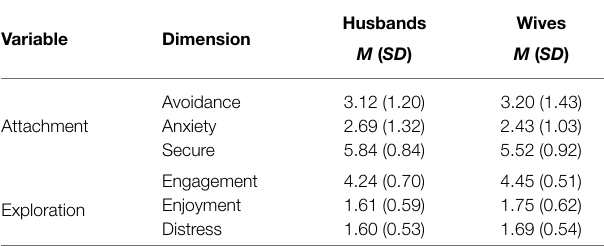
TABLE 3 | The mean scores and standard deviations of attachment dimensions and exploratory behavior for husbands and wives.